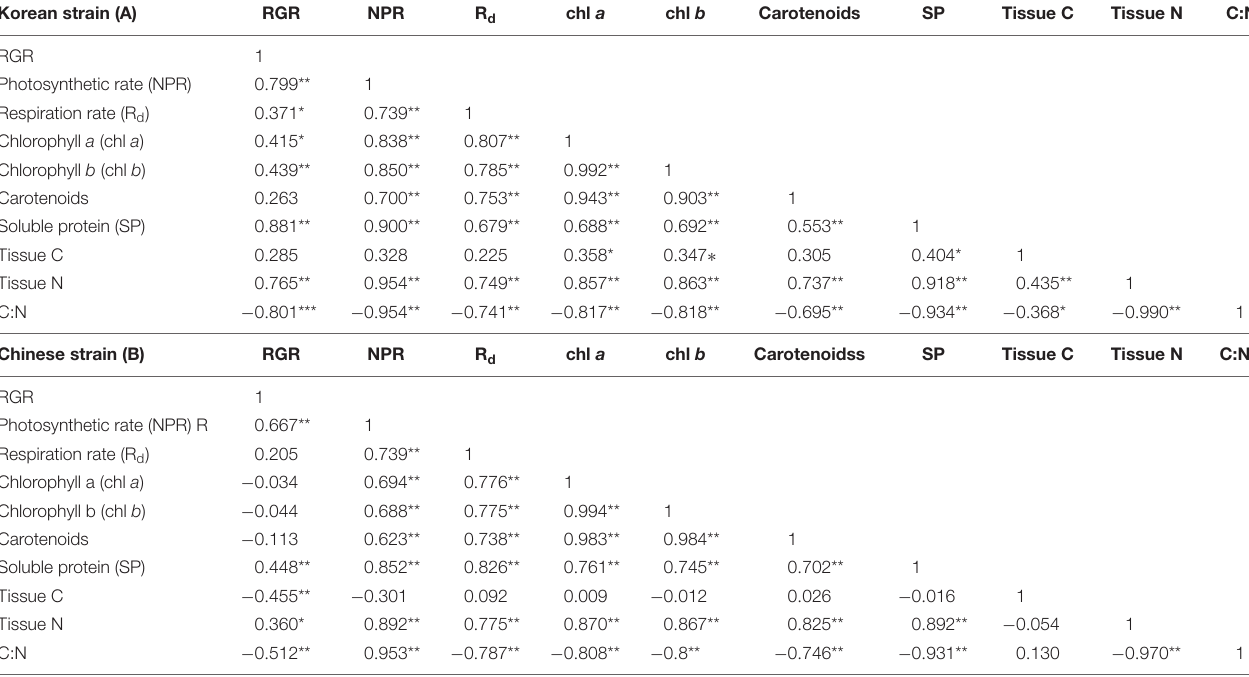
TABLE 1 | Pearson correction coefficients ( n = 36) between physiological and biochemical parameters between a Korean strain (A) and Chinese strain (B) of Ulva prolifera . Korean strain (A) RGR NPR chl b Carotenoids SP